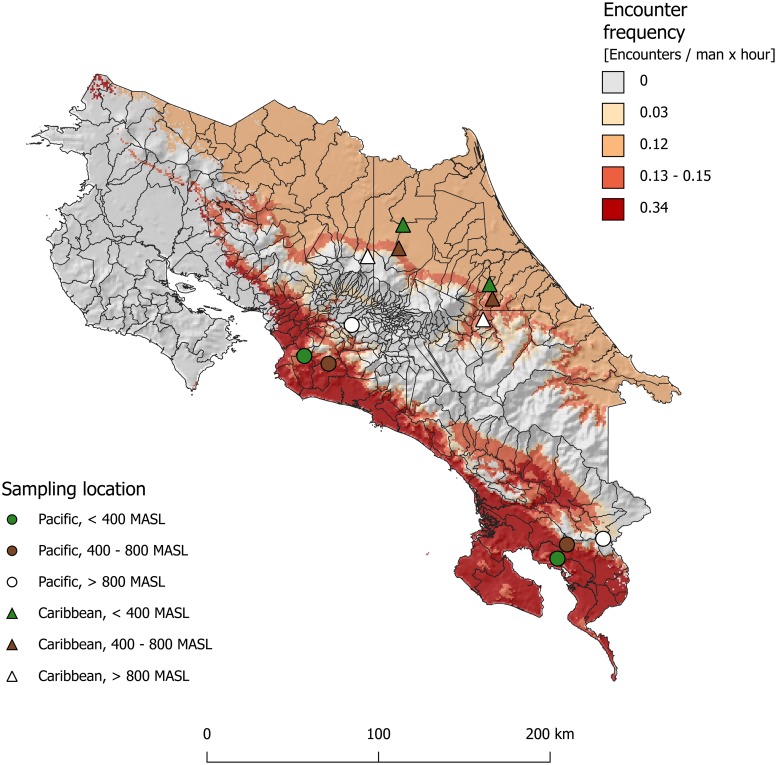
Sampling locations and predicted encounter frequency of Bothrops asper over its distribution.Each symbol corresponds with a sampling location. Circles are sampling locations in the Pacific versant, while triangles represent locations in the Caribbean versant. Green symbols are lowlands locations (Altitude below 400 m.a.s.l.), brown symbols are midlands locations (Altitude between 400 m.a.s.l and 800 m.a.s.l.), and white symbols are highlands locations (Altitude above 800 m.a.s.l.). Gray areas are places where the environmental niche model predicted absence for the study species. The other map colors show the value of the extrapolated encounter frequency. Encounter frequency was higher in the Pacific versant than in the Caribbean, and it tends to decrease with altitude. Map was produced by using QGIS Geographic Information System, Open Source Geospatial Foundation Project. http://qgis.osgeo.org.